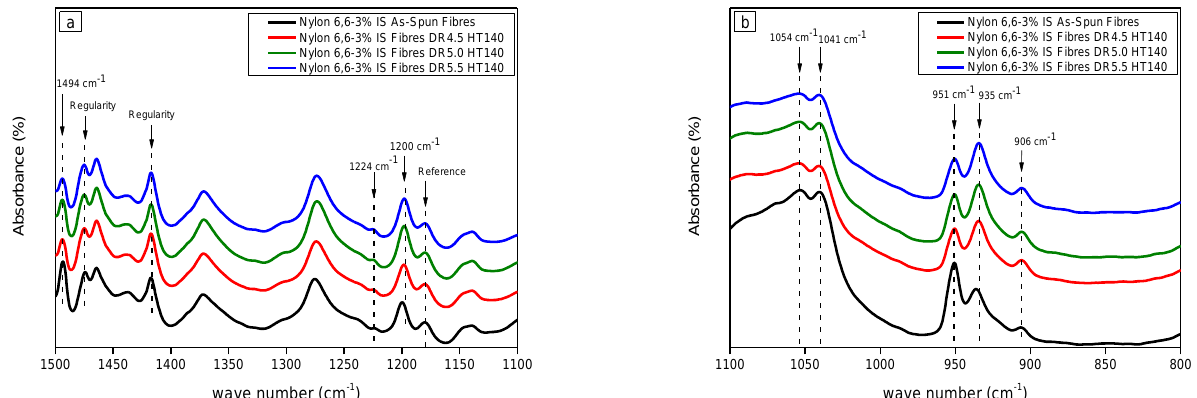
Figure 2. The FTIR spectra of the as-spun and drawn salt-confined nylon 6,6 fibres at the drawing temperature of 140 °C at the band regions of ( a ) 1500 – 1100 cm − 1 and ( b ) 1100 – 800 cm − 1 .